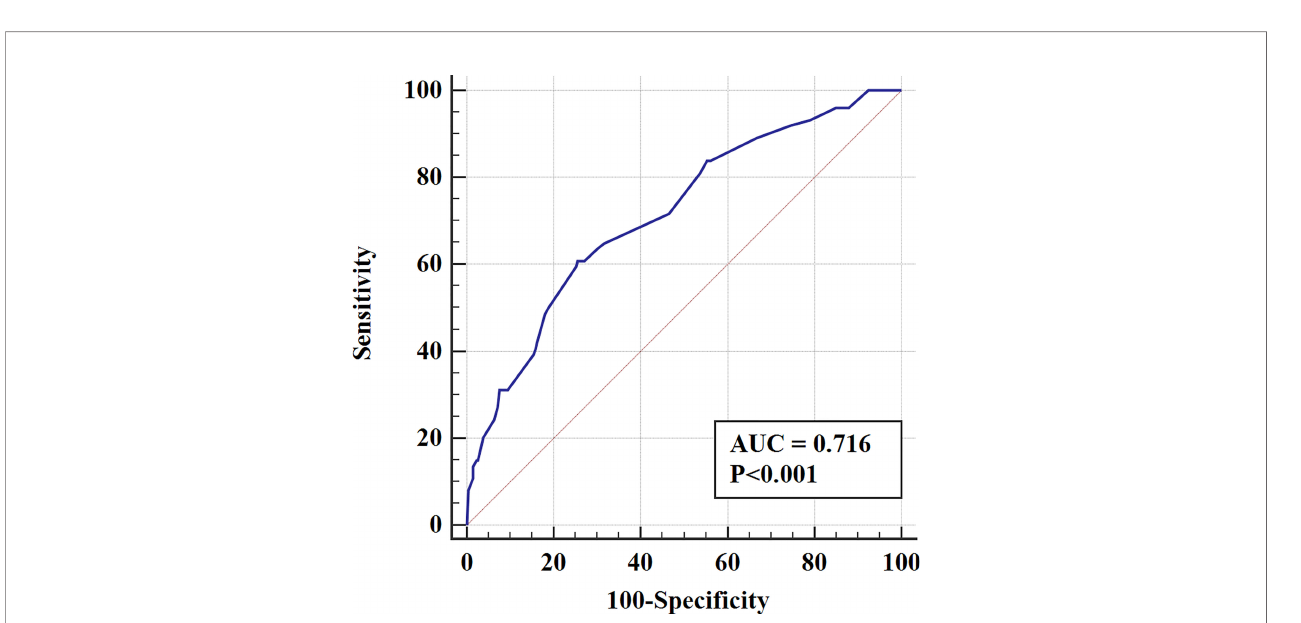
FIGURE 4 | The ROC curve for assessing the discrimination of the nomogram in predicting all cause of early death in the validation